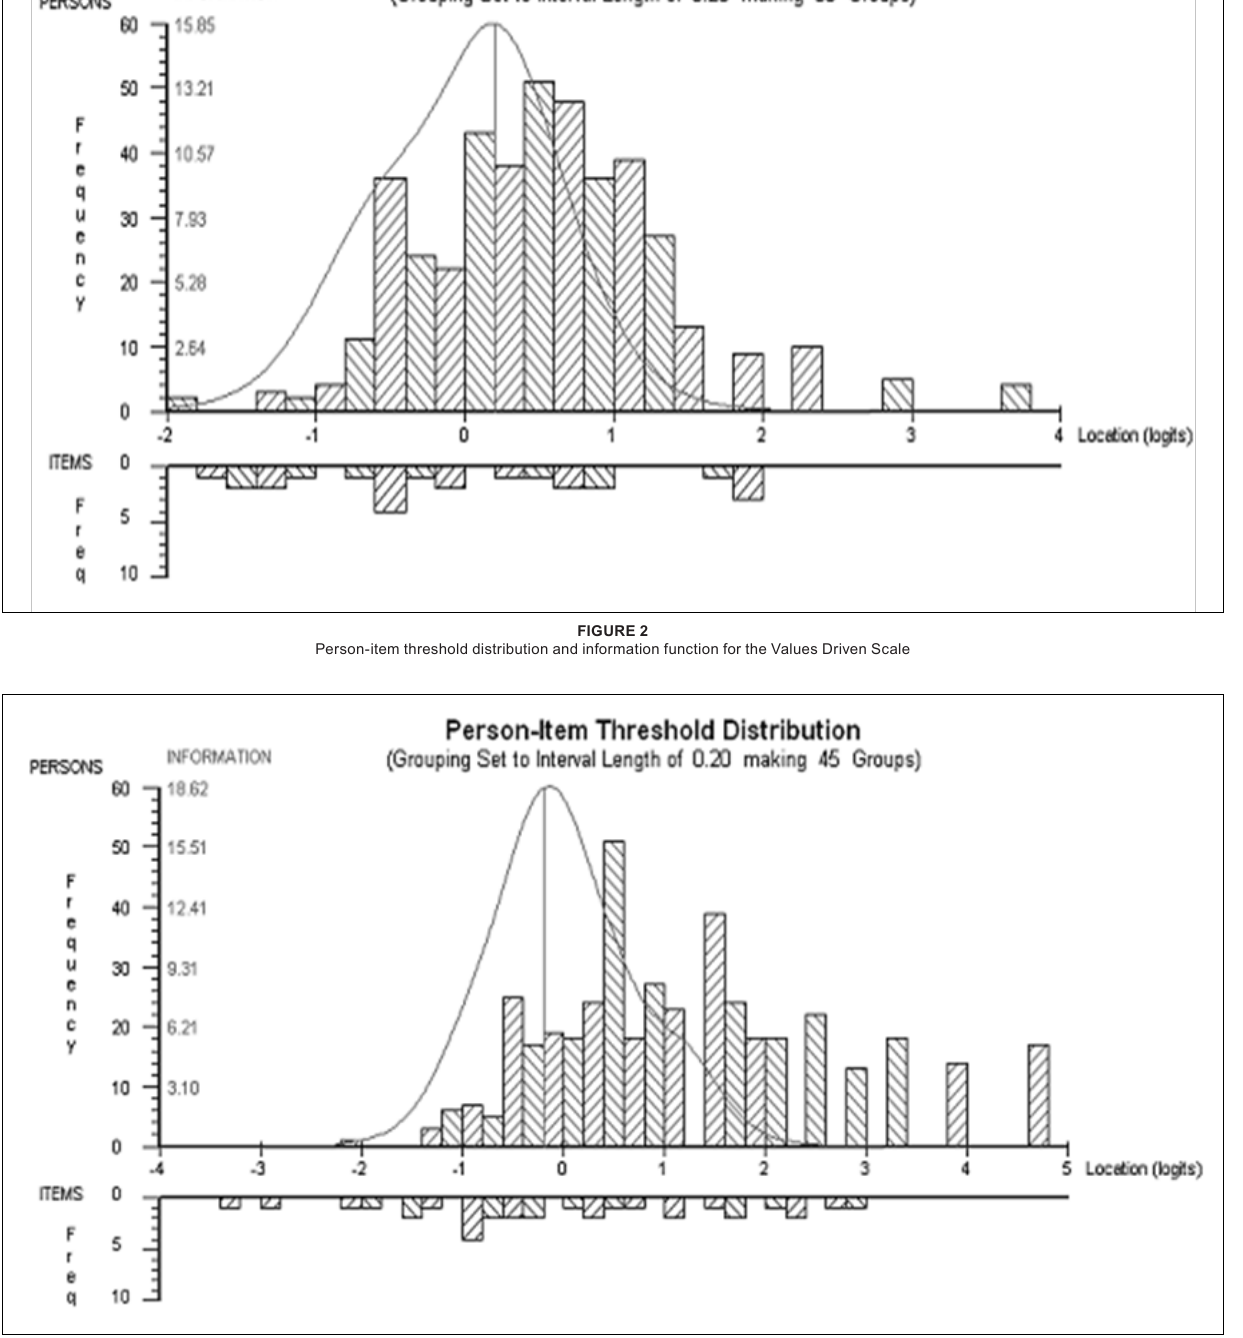
FIGURE 3 Person-item threshold distribution and information function for the Boundaryless Mindset